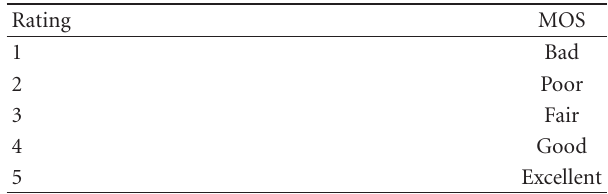
Table 2: Scales used in MOS.